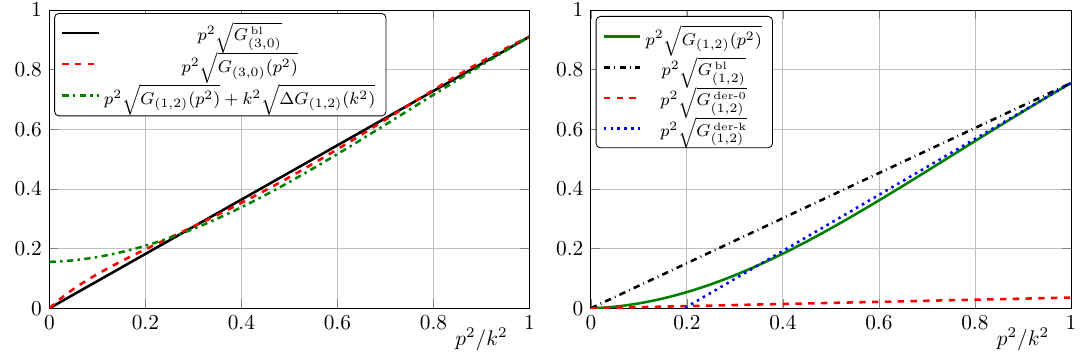
Figure 2: Displayed are the momentum-dependent Newton couplings eval- uated on the quenched bilocal fixed point using effective universality for (cid:198) ( p 2 ) and G ( the momentum-independent couplings, see (17). Left: p 2 3,0 ) (cid:198) ( p 2 ) − k 2 (cid:198) ∆ G ( k 2 ) , see (19). The black lines guides the eye and cor- p 2 G ( ( 1,2 ) 1,2 ) (cid:113) (cid:198) ( p 2 ) as well as G bl G ( . Right: p 2 responds to the bilocal approximation p 2 1,2 ) ( 3,0 ) local and bilocal approximations to the momentum dependence of